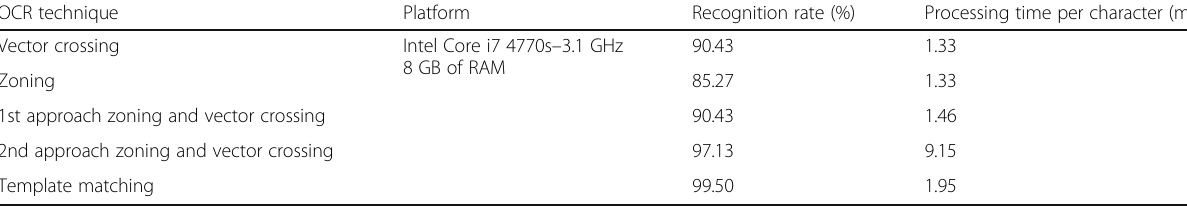
Table 3 Performance of proposed OCR algorithms based on software implementation — MATLAB OCR